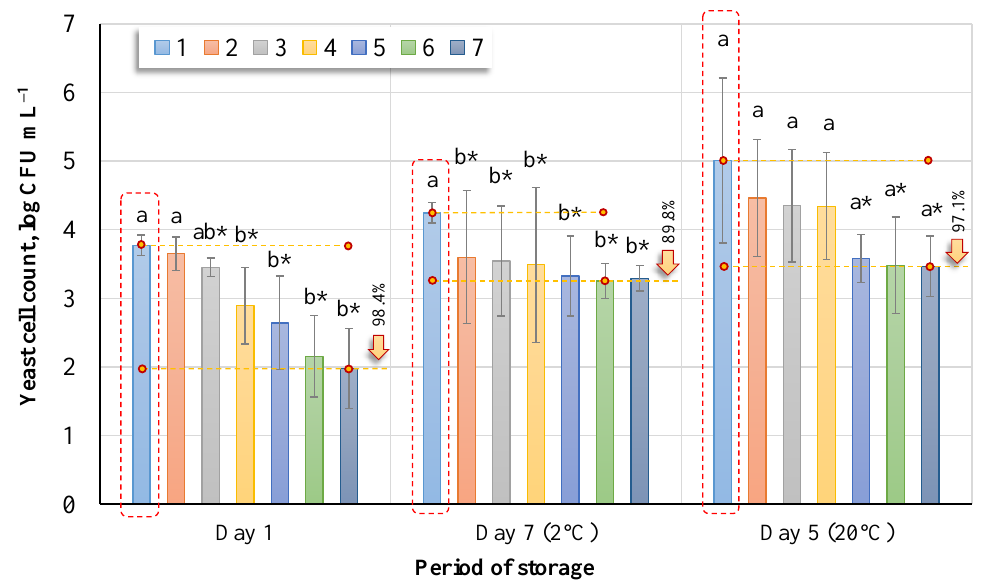
Figure 5. Changes in the yeast colonies count in birch sap: 1 (control)—not ozonated sap (initial); 2—sap ozonated for 5 min; 3—sap ozonated for 10 min; 4—sap ozonated for 15 min; 5—sap ozonated for 20 min; 6—sap ozonated for 25 min; 7—sap ozonated for 30 min. Significant, substantial differences are distinguished by different letters (Tukey HSD test). Single letters indicate that there is no significant difference. Differences were considered significant when p values were less than 0.05 ( n = 18). In the Dunnett test, significant differences between the control group (No. 1) and the treatment group are marked with an asterisk “*” .